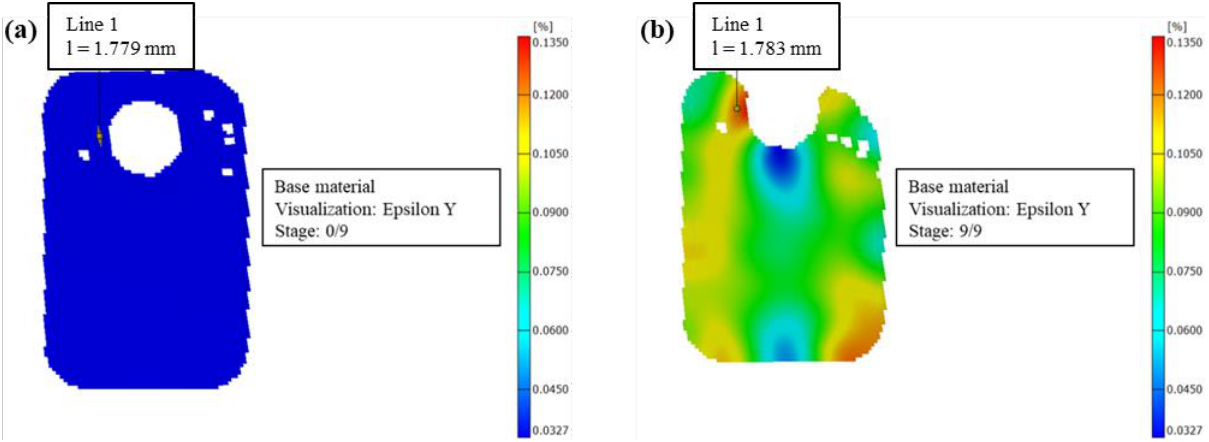
Figure 7. Nimonic 263 sheet, base material digital image correlation (DIC) measurement 1: ( a ) unloaded state, and ( b ) axial force 5 kN.